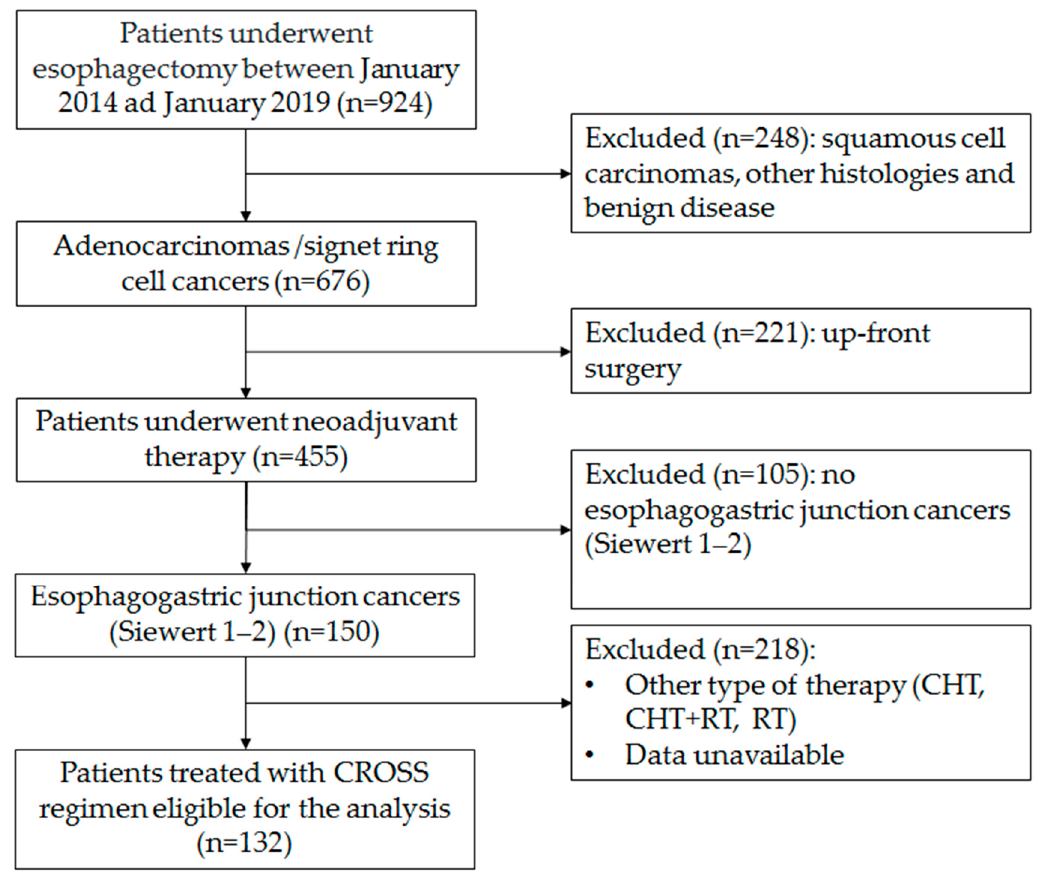
Figure 6 . Flow-chart of the enrolment procedure . Figure 6. Flow-chart of the enrolment